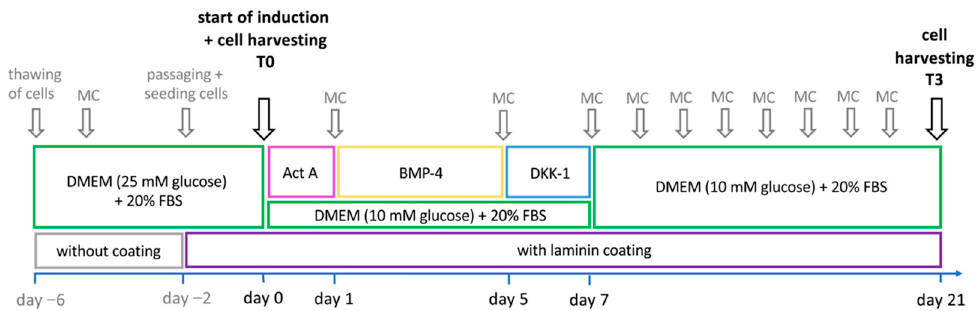
Figure 1. Study design of the cardiomyogenic differentiation experiments using the induction factors activin A (Act A), bone morphogenetic protein-4 (BMP-4) and Dickkopf-1 (DKK-1). In both sub-experiments, equine adipose-derived stem cells were induced with Act A on day 0, with BMP-4 from day 1 to 5 and with DKK-1 from day 5 to 7 in laminin-coated cell culture flasks. Further cultivation from day 7 on was performed in a modified basal medium, and, on day 21, cells were harvested for subsequent molecular–biological studies. Abbreviations: DMEM, Dulbecco’s Modified Eagle’s Medium; FBS, fetal bovine serum; MC, medium change; T0, time point day 0; T3, time point 3 weeks after induction.